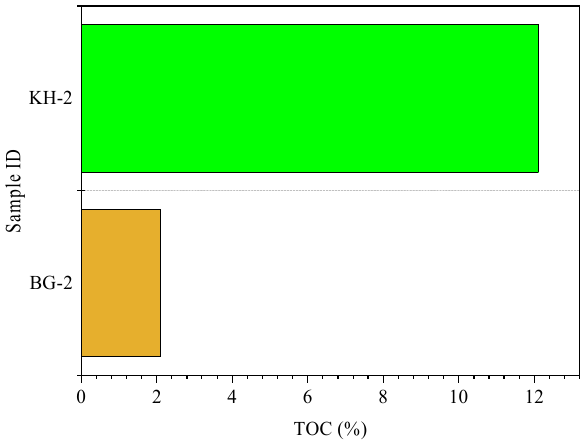
Figure 6. The total organic carbon (TOC) percentage in BG-2 and KH-2 shales.